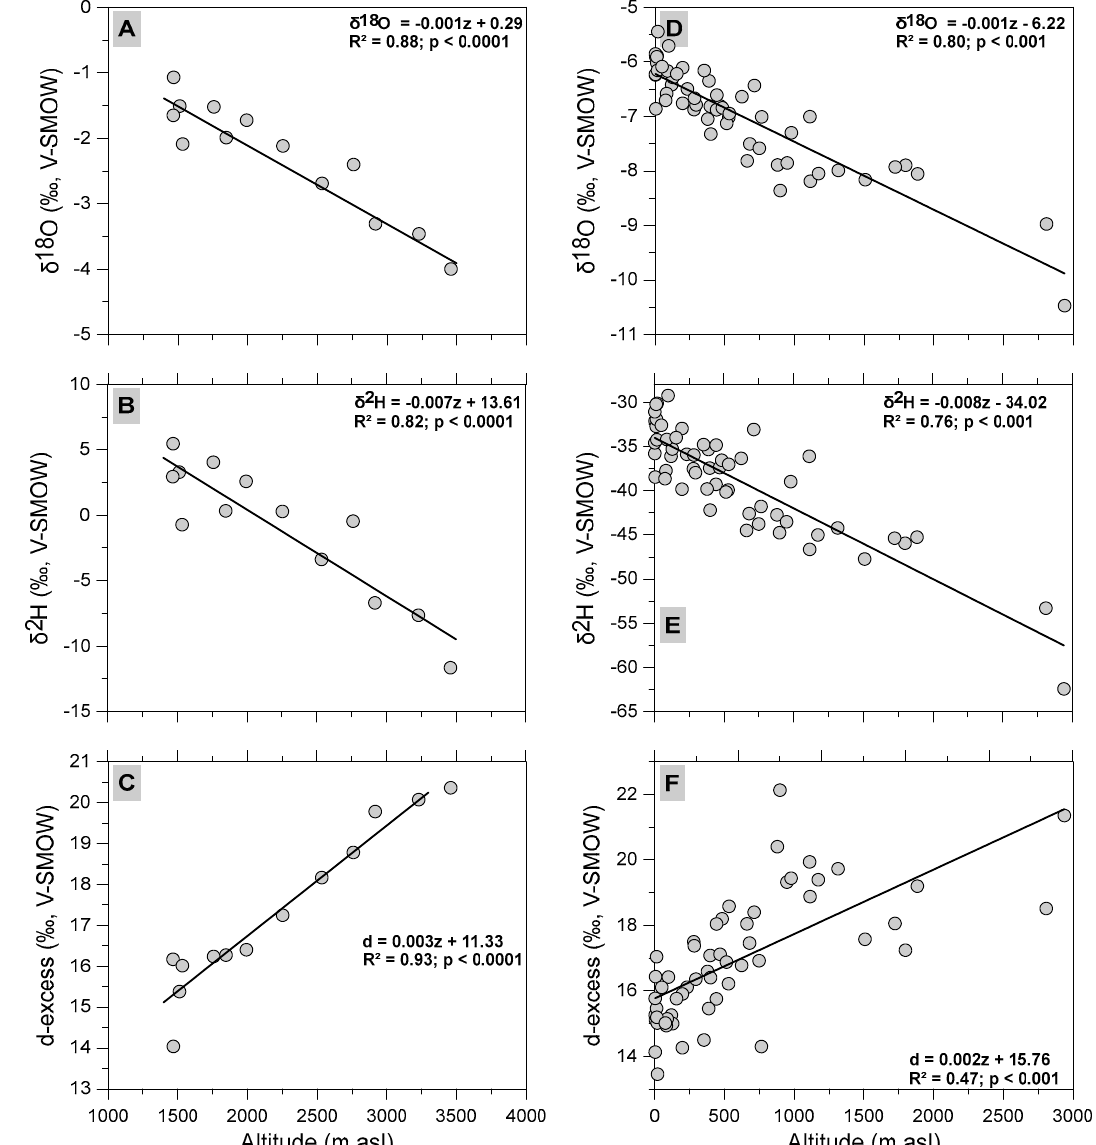
Figure 4. Mean precipitation-weighted δ 2 H, δ 18 O and d-excess values plotted against altitude in Virunga, ( A – C ) located on the limit between Central and Eastern Africa, within the western branch of the East African Rift System, and southern Italy ( D – F ) in the Central Mediterranean (data are from Stromboli and Sicily).